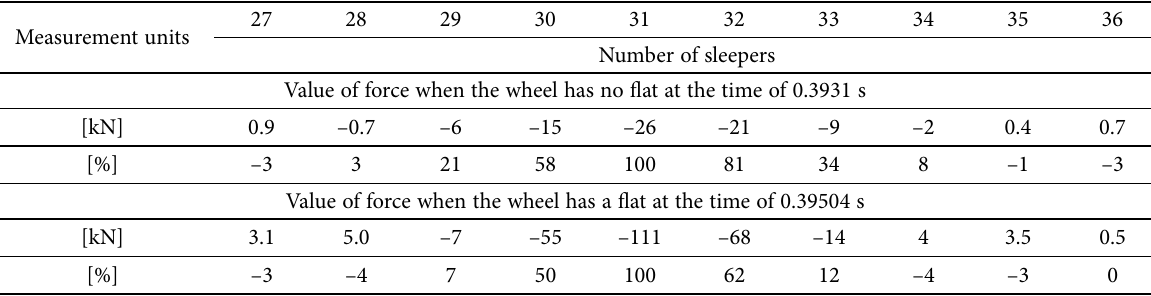
Table 2. Peak forces operating on sleepers from the rail (through pad) and their percentages when the wheel has or has no flat Measurement